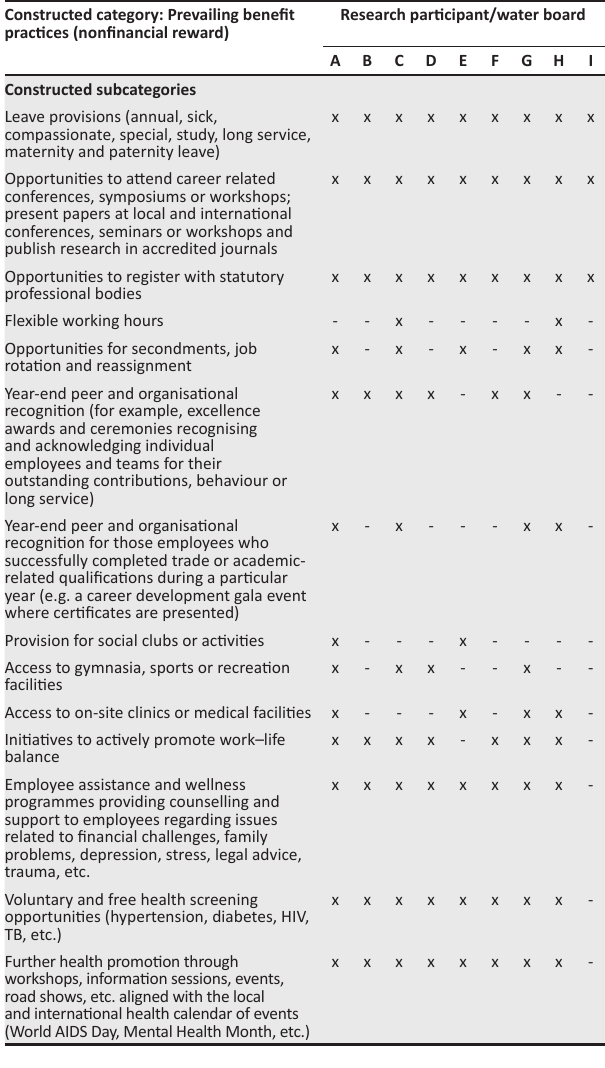
TABLE 3: Focused coding for prevailing compensation practices. TABLE 4: Focused coding for prevailing benefit